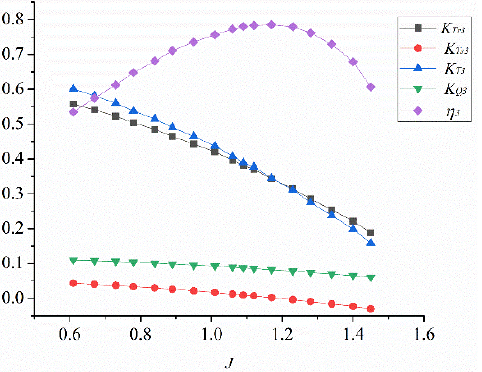
Figure 30. Hydrodynamic performance curves of pump-jet designed by inverse design method.